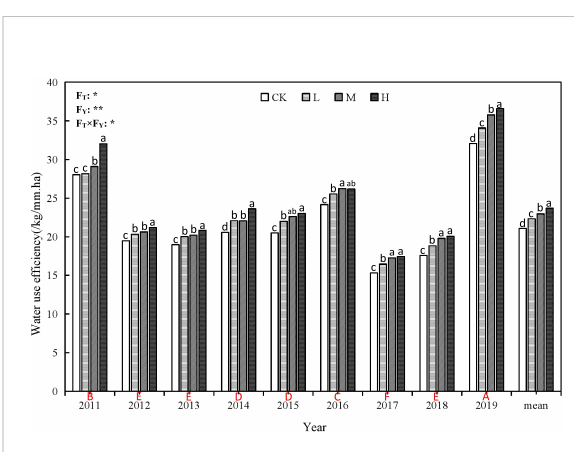
FIGURE 5 Water use ef fi ciency of winter wheat under different rate ofsuper absorbent polymer and precipitation from 2011 to 2019.CK, 0 kg ha-1; L, 15 kg ha-1; M, 30 kg ha-1; H, 45 kg ha-1.Different lower- case letters above columns indicate signi fi cantdifferences between four treatments in the same year by Scheffe ́ test (P< 0.05). Different upper-case letters under columnsindicate signi fi cant differences between mean value of fourtreatments in different years by Scheffe ́ test (P< 0.05). FT, FY andFT×FY mean F-values of treatments, years and their interactionsin variance analysis respectively. “ * and ** ” indicate difference atthe 0.05 and 0.01 levels,